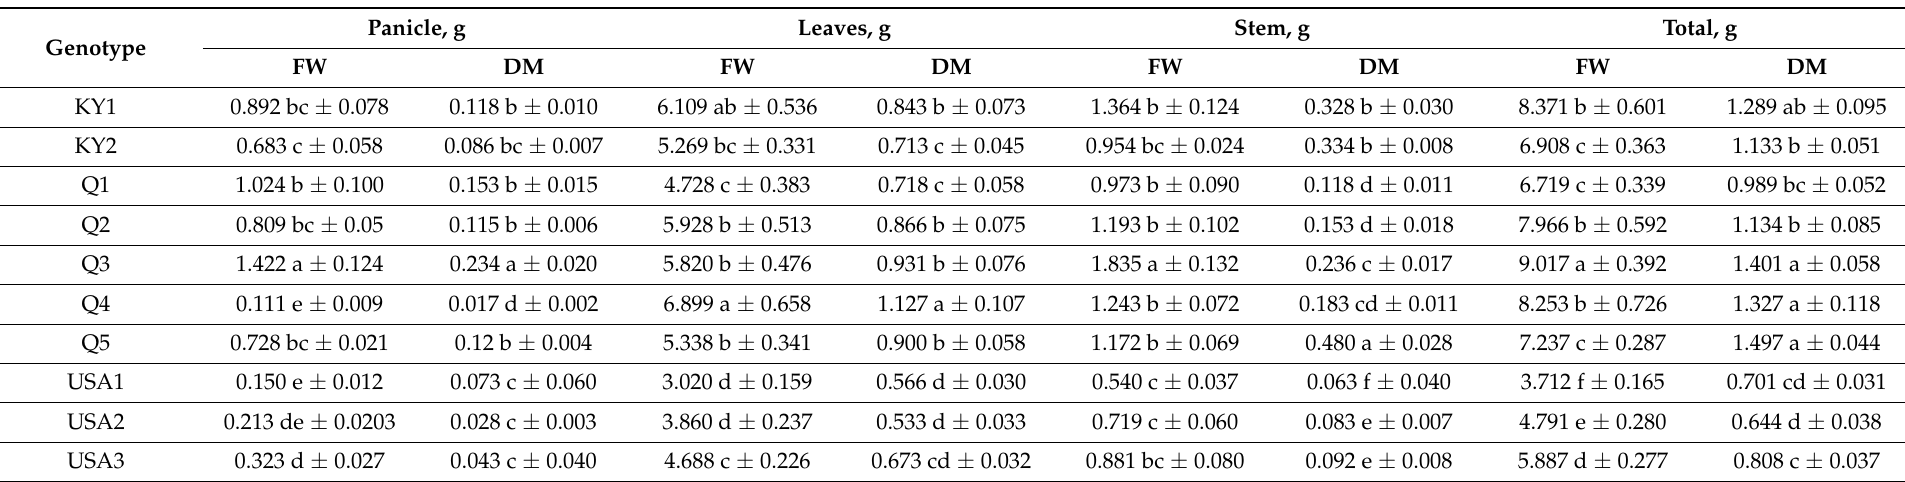
Table 1. Fresh weight (FW, g) and dry matter (DM, g) of the upper aerial parts of cultivated quinoa